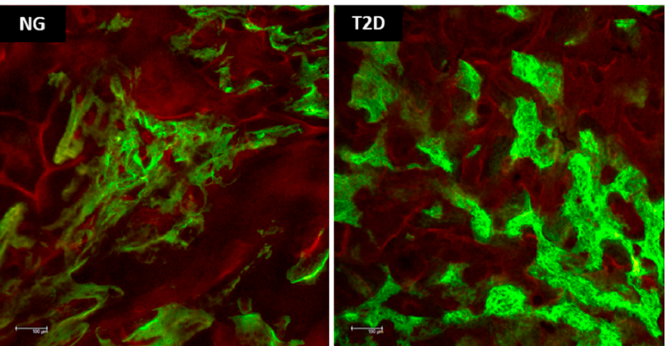
Figure 7. Confocal microscopy photomigrographs. The photomicrographs obtained by a confocal microscopy, show the fluorochromes precipitation. In green: Calcein precipitation in the bone matrix; In red: Alizarin red precipitation in the bone matrix. Original 10× magnification.